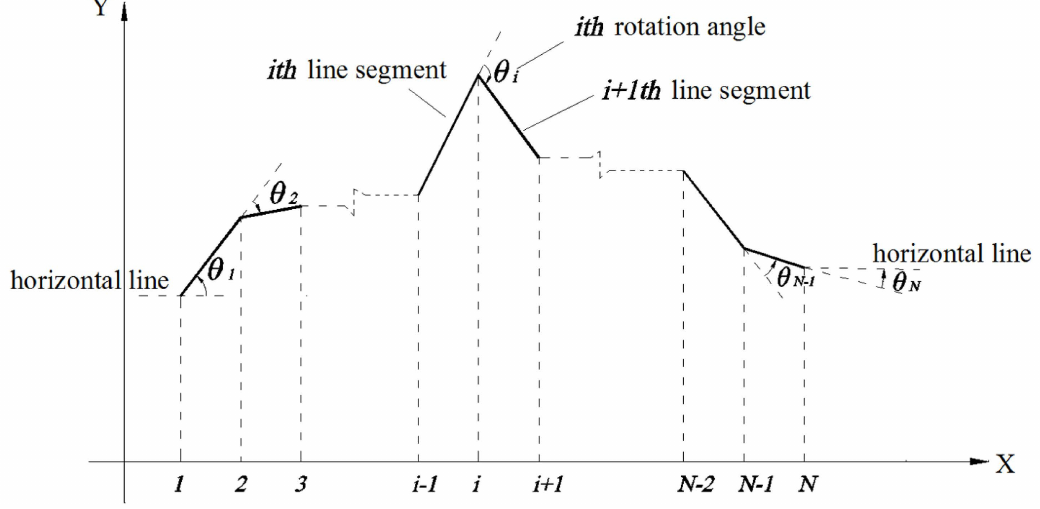
Figure 1. Diagram of rotation angle and line segment of